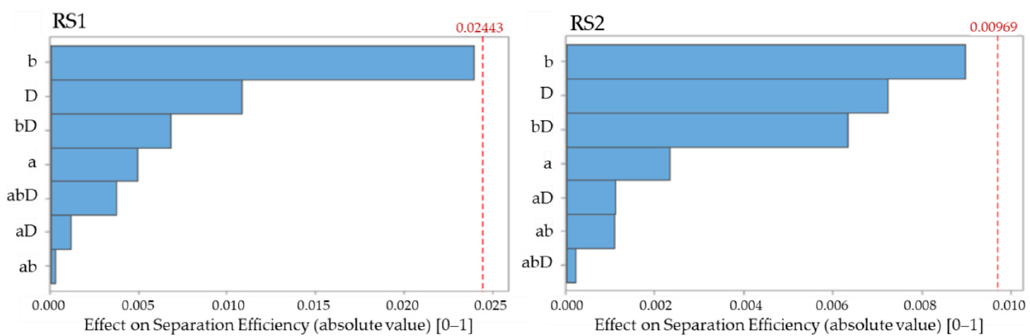
Figure 6. Pareto chart for the oil quality for both DOE variants.